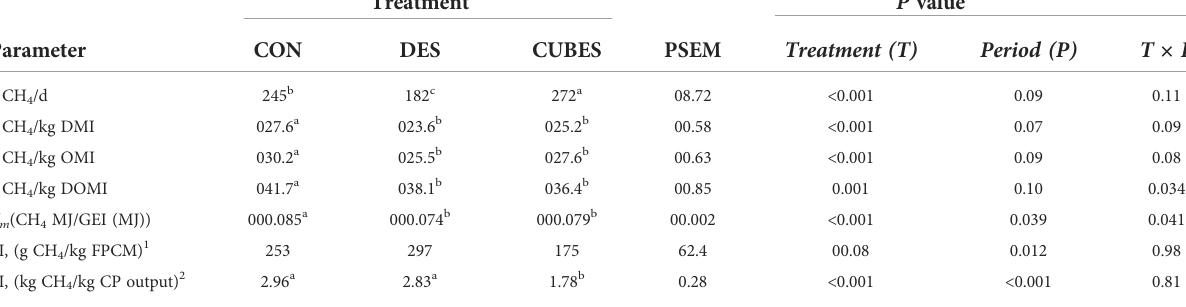
TABLE 8 Mean daily methane production (DMP), methane yield (MY), methane produced per organic matter intake (OMI) and digested OMI (DOMI), methane conversion factor (Y m ) and methane emission intensity (EI; g CH 4 /kg of fat and protein corrected milk; FPCM) of crossbred cows ( n =12) fed on either a control diet (CON) consisting mainly of Urochloa brizantha var Xaraes hay alone or supplemented with either Desmodium intortum hay (DES) or a commercial dairy supplement